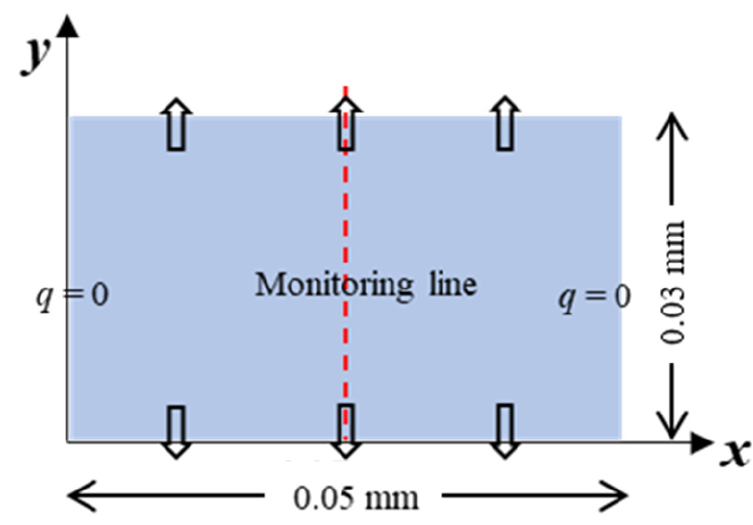
Figure 14. Model setup and boundary conditions.